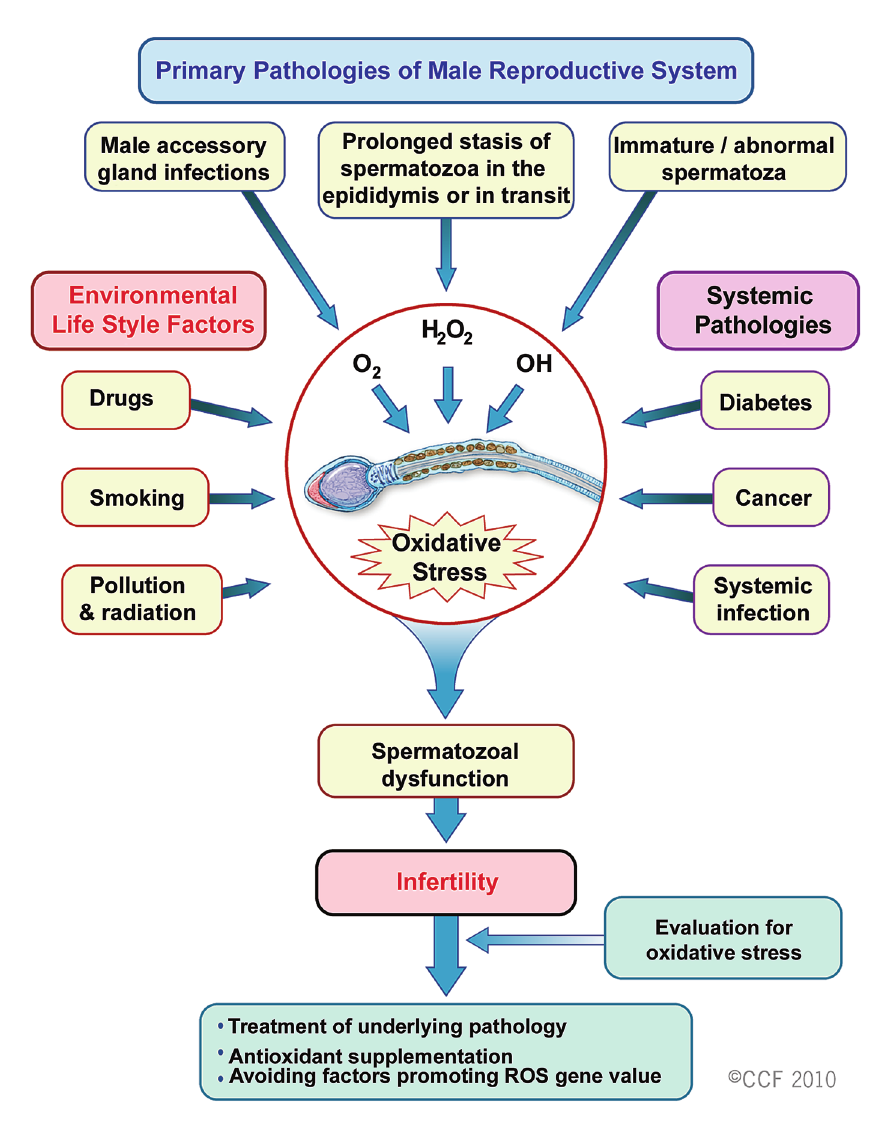
Figure 2 – Relationship of the primary pathologies of the male reproductive system, oxidative stress and